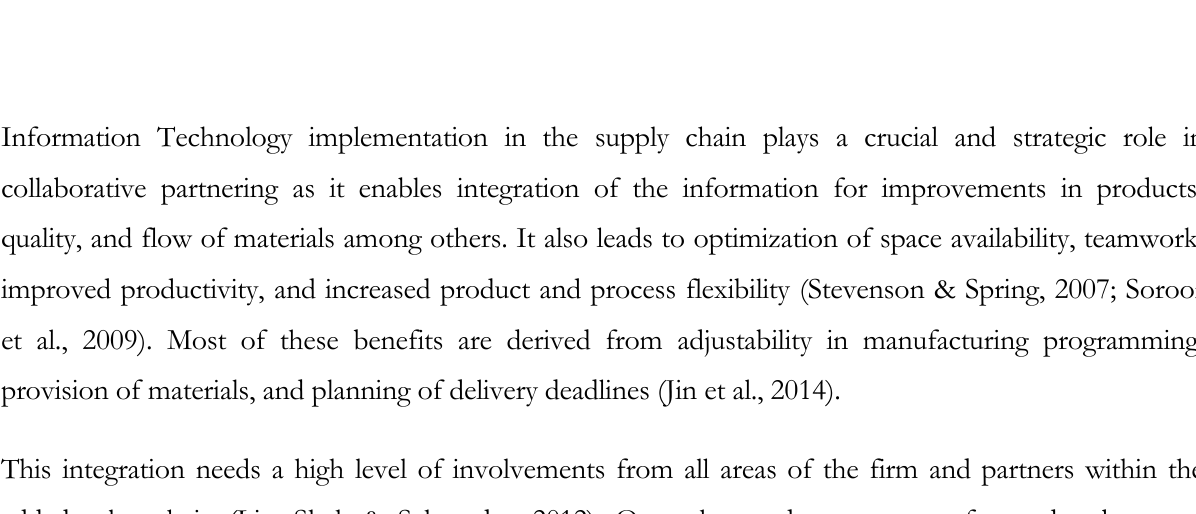
Table 1. Manufacturing flexibility dimensions (Gerwin,